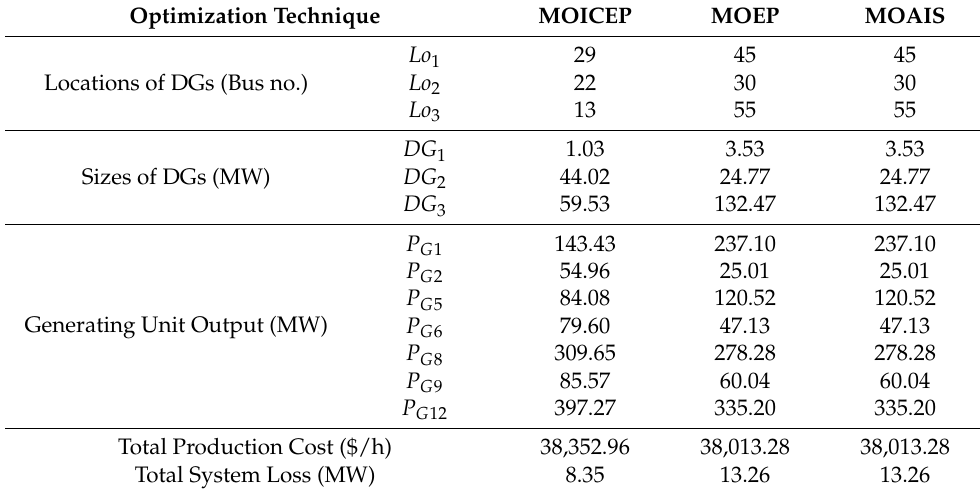
Table 21. Results of the integrated ED problem with a valve-point loading effect and DG installation of the IEEE 57-Bus RTS ( w 1 = 0.1 and w 2 = 0.9). Optimization Technique MOICEP MOEP MOAIS Locations of DGs (Bus no.)